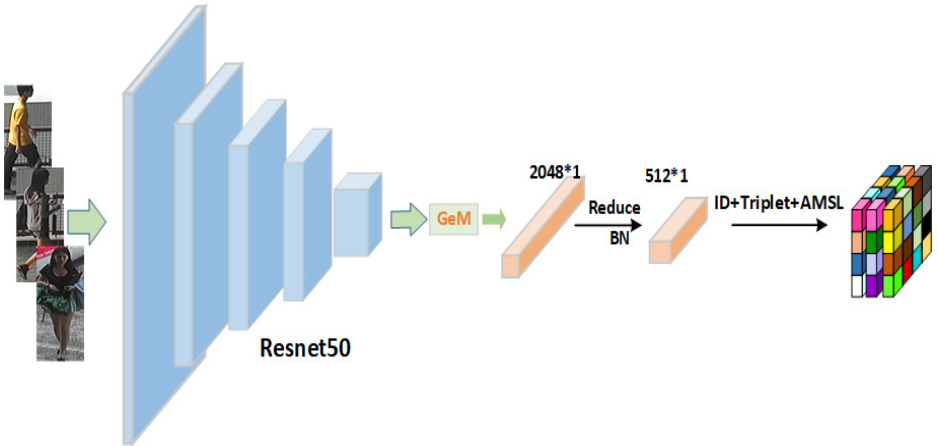
Figure 2. Basic structure of the proposed baseline.